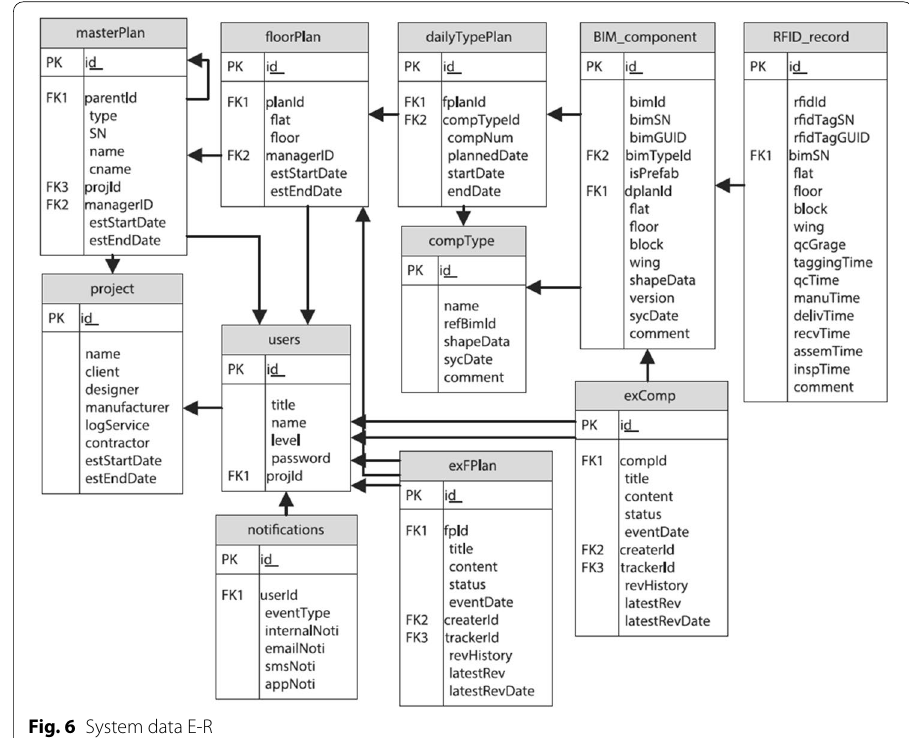
Fig. 6 System data